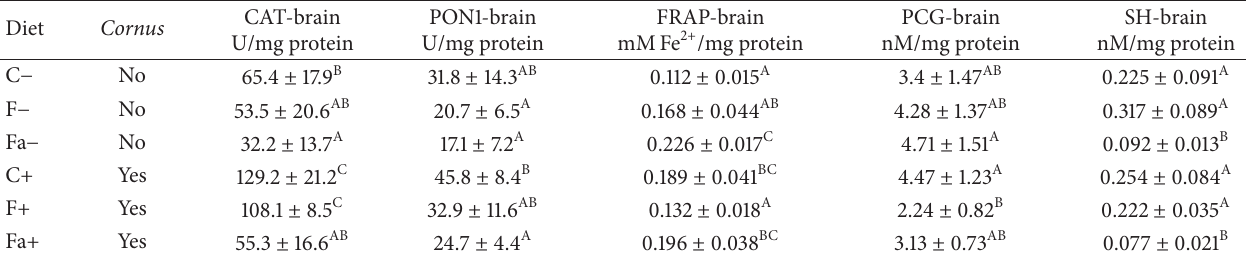
Table 2: Activity of oxidative stress markers (CAT, PON1, FRAP, PCG, and SH) marked in brain tissue homogenates in Wistar rats. Data are presented as means from independent measurements ± standard deviation (SD). Different letters in the same columns indicate significant differences according to Tukey’s test ( 𝑃 < 0.05